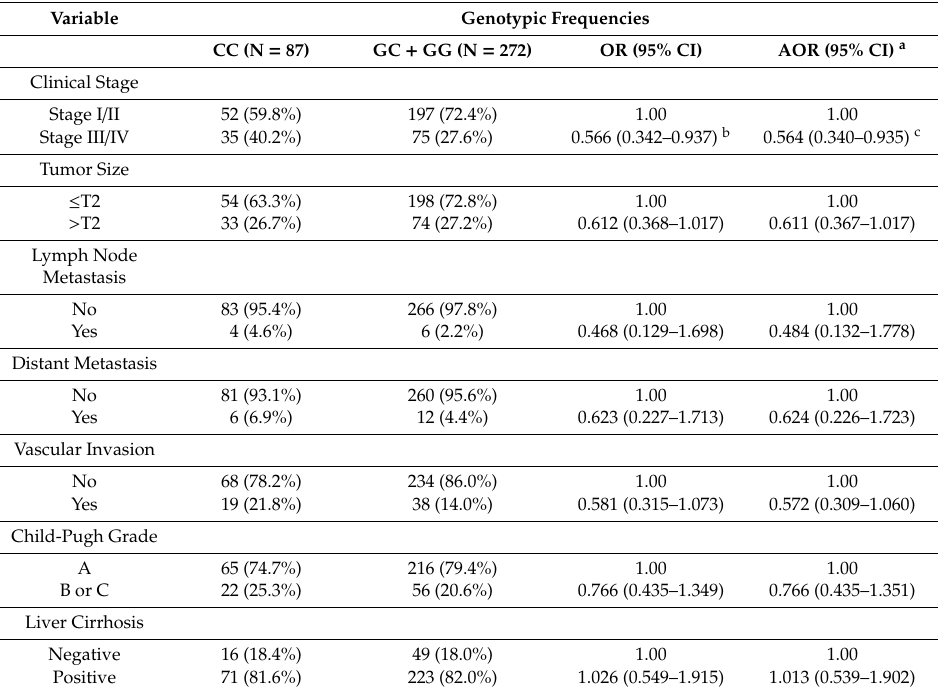
Table 3. Odds ratio (OR) and 95% confidence interval (CI) of clinical status and H19 rs3024270 genotypic frequencies in 359 HCC patients.